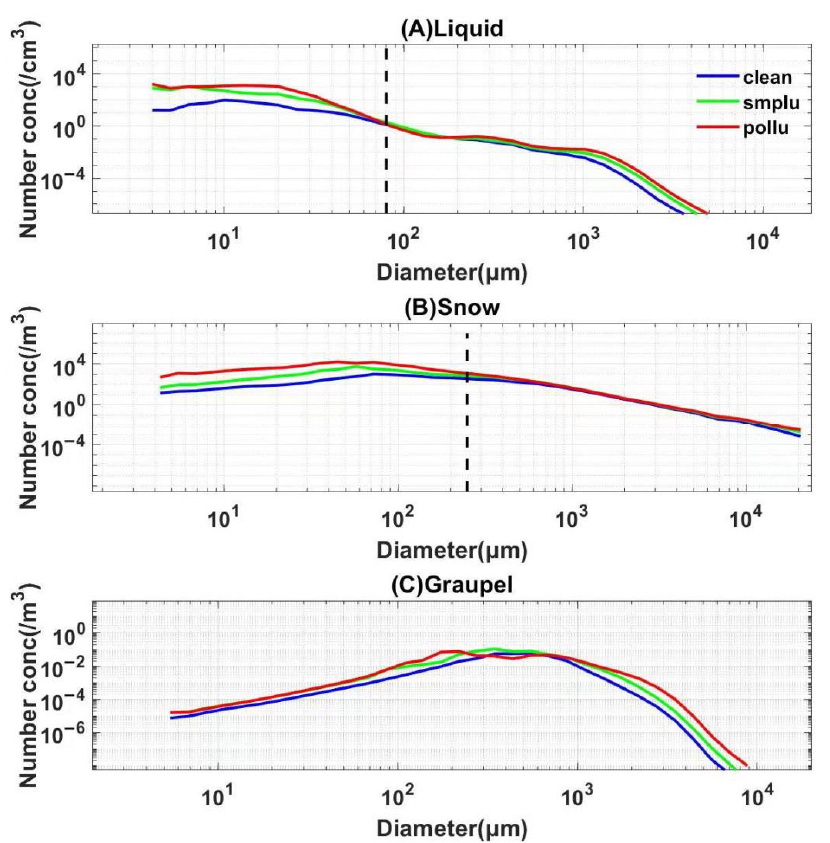
Figure 2. Size distribution of ( A ) cloud droplets/raindrops, ( B ) ice crystals/snow, and ( C ) graupel particles in clean (blue solid line), moderate pollution (green solid line), and polluted (red solid line). The black dashed line is the threshold of ( A ) cloud droplets/raindrops (80 μ m) and ( B ) ice crystals/snow (250 μ m).